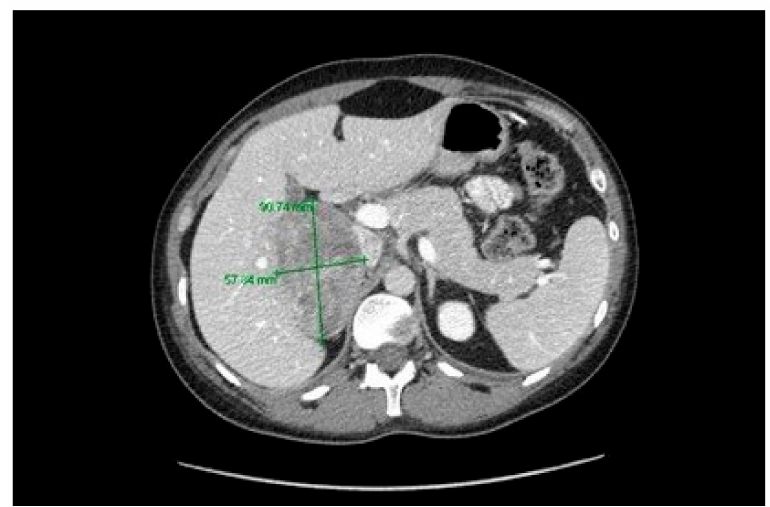
Figure 2. Computed tomography revealing the 9.1 × 5.8 cm right adrenocortical